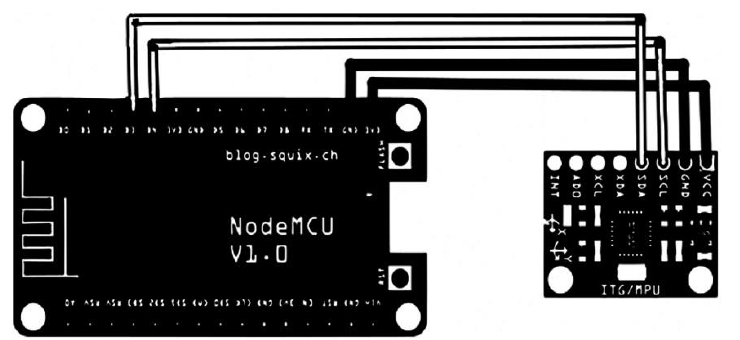
Figure 1. Circuit and schematic design MPU6050 accelerometer sensor with MCU ESP8266.